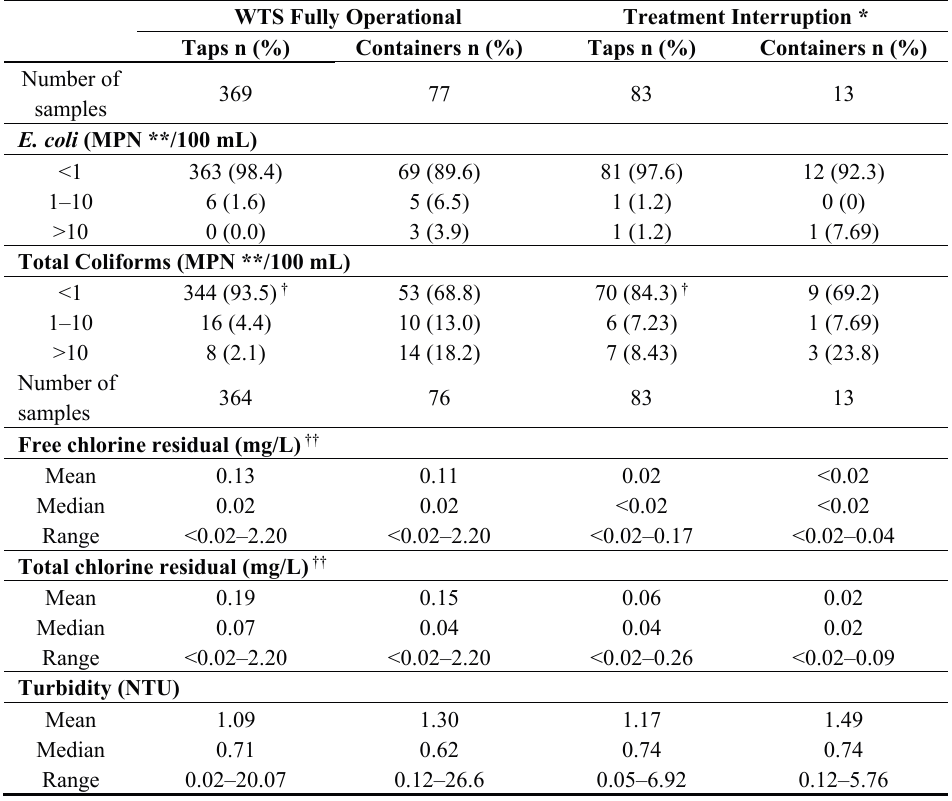
Table 3. Quality of water from samples collected from taps and storage containers when water treatment systems were fully operational and during treatment